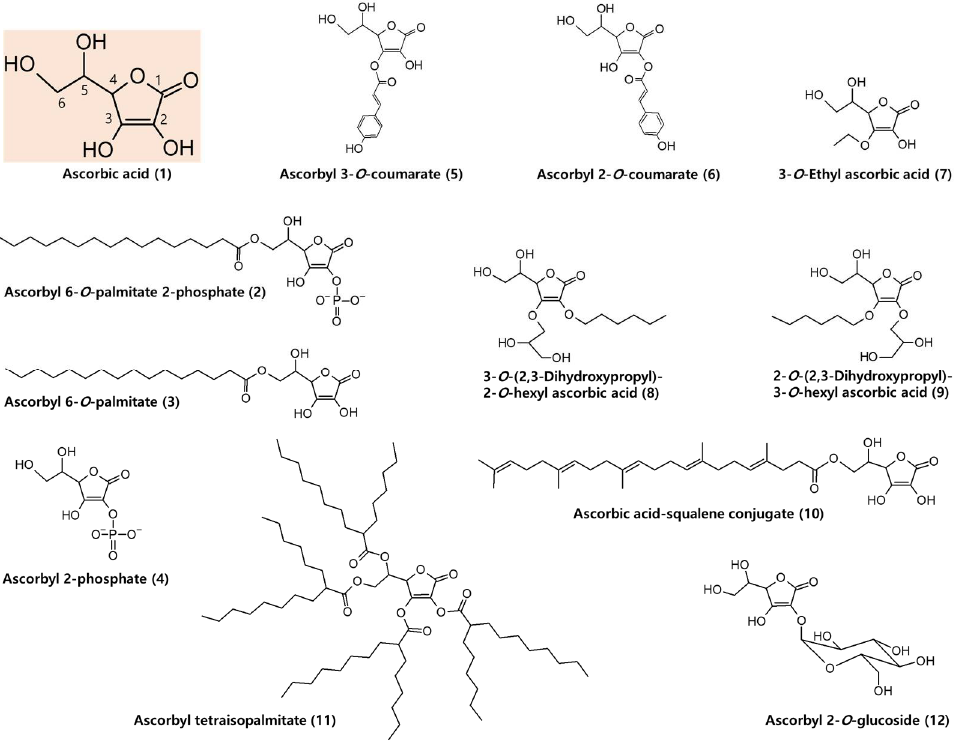
Figure 2. Chemical structures of ascorbic acid and its derivatives. Hydrophobic AA precursors can pass through the cell membrane and enter the cell by simple diffusion and can be enzymatically hydrolyzed in the cell to regenerate AA. For